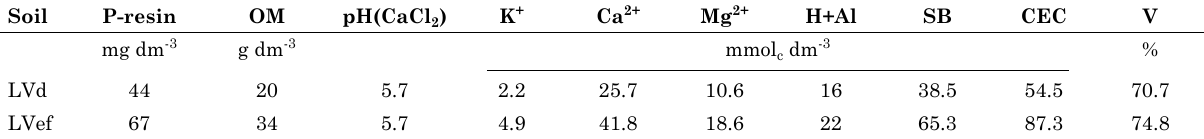
table 1. Chemical analysis of eutroferric Latossolo Vermelho (lVef) and dystrophic Latossolo Vermelho (LVd) prior to the experiment in the growing season 2012/2013 soil P-resin